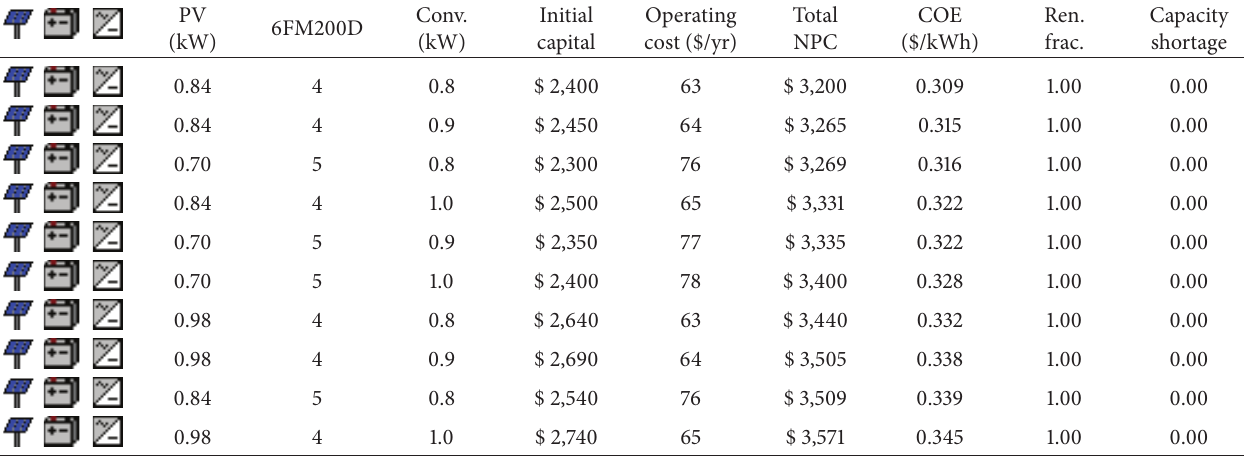
Table 4: Optimum solution for the proposed PV system using HOMER.